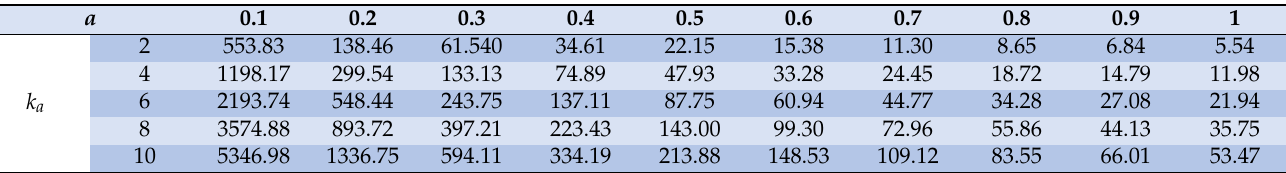
Table 2. Buckling loads vs. k a